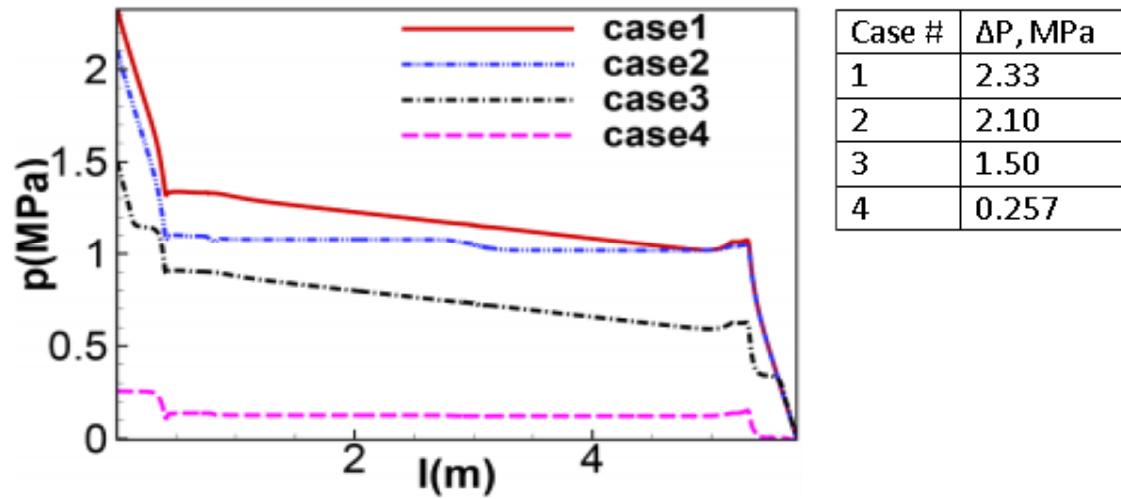
Figure 18. Pressure drop along the module centerline ( left ) and the summary of the MHD pressure drop for the four insulation cases ( right ).